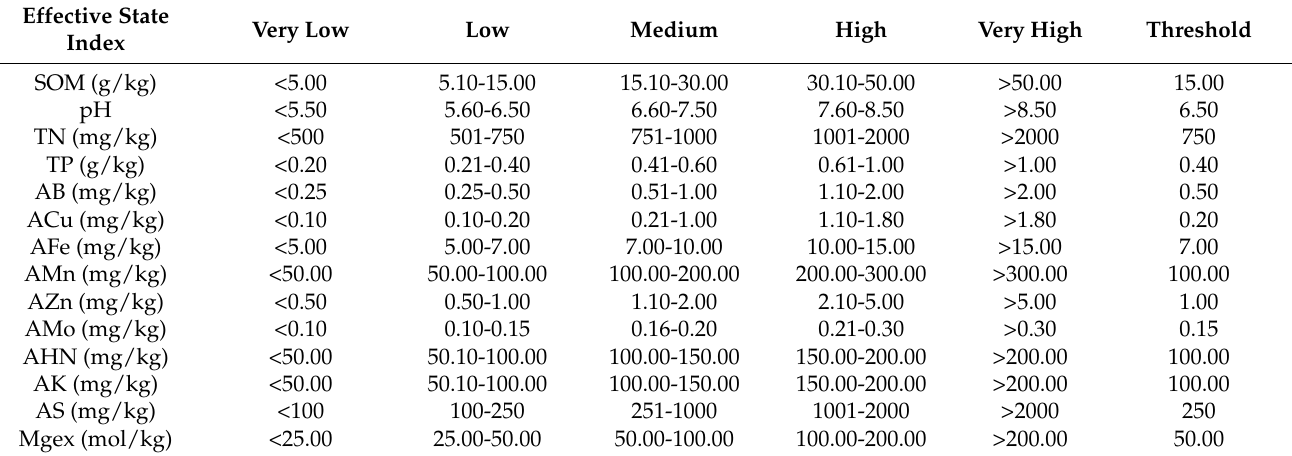
Table 3. Classification standard for soil nutrient content.